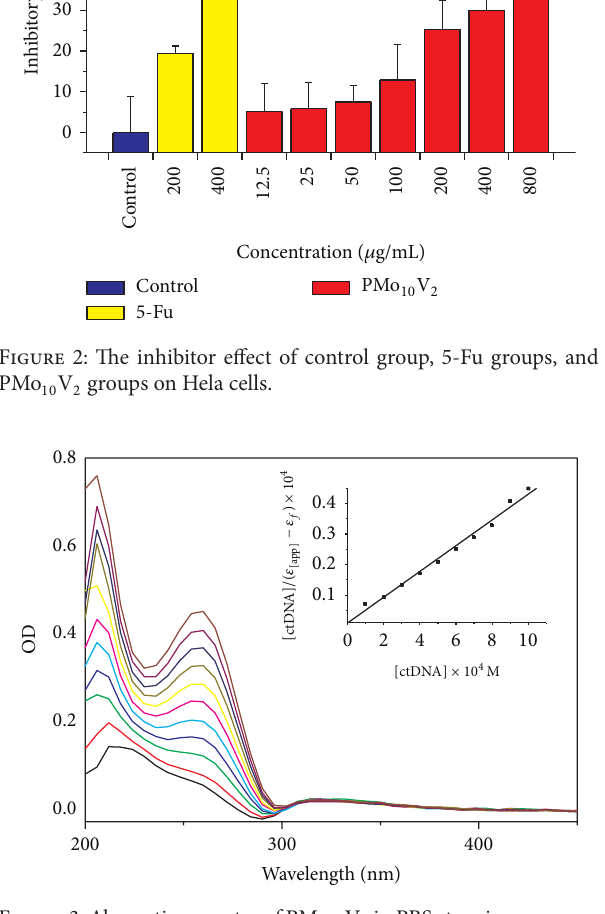
Figure 3: Absorption spectra of PMo 10 V 2 in PBS at various concen- trations of ctDNA. It shows the absorbance changes upon increasing ofctDNAconcentrations.Insert:changesof[ctDNA]/( 𝜀 𝑎 −𝜀 𝑓 )versus [ctDNA] for titration of PMo 10 V 2 .